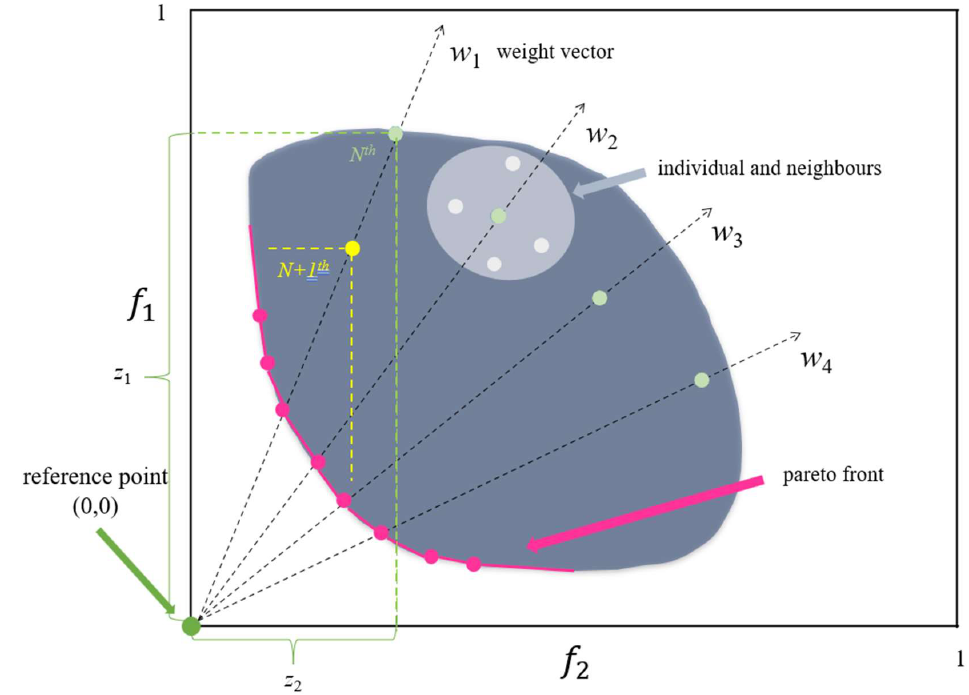
Figure 4. The procedure of